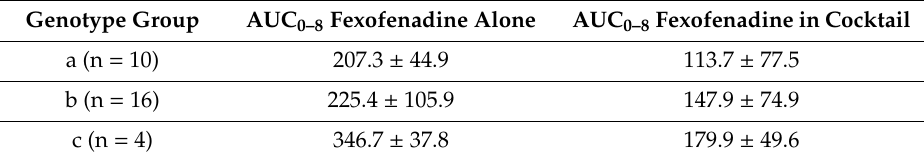
Table 3. Stratification of fexofenadine AUC according to MDR1 genotypes deduced from SNPs 2677G > T / A and 3435C >